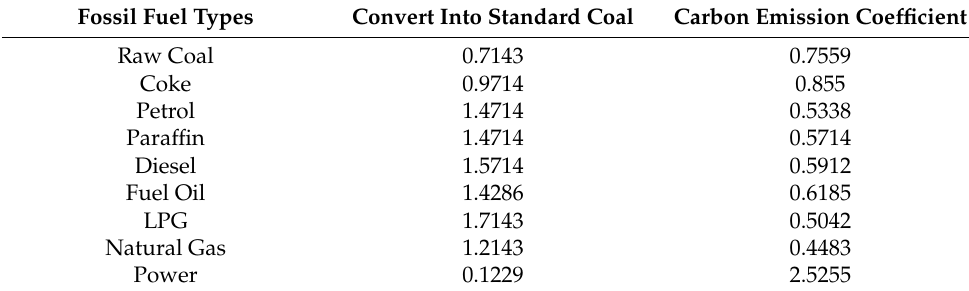
Table 5. Fossil energy carbon emission